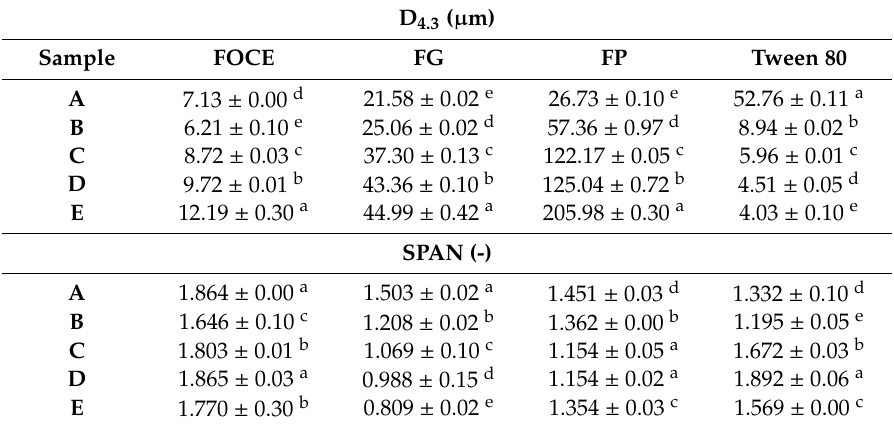
Table 2. D 4,3 and SPAN values of emulsions prepared with various content of oil.